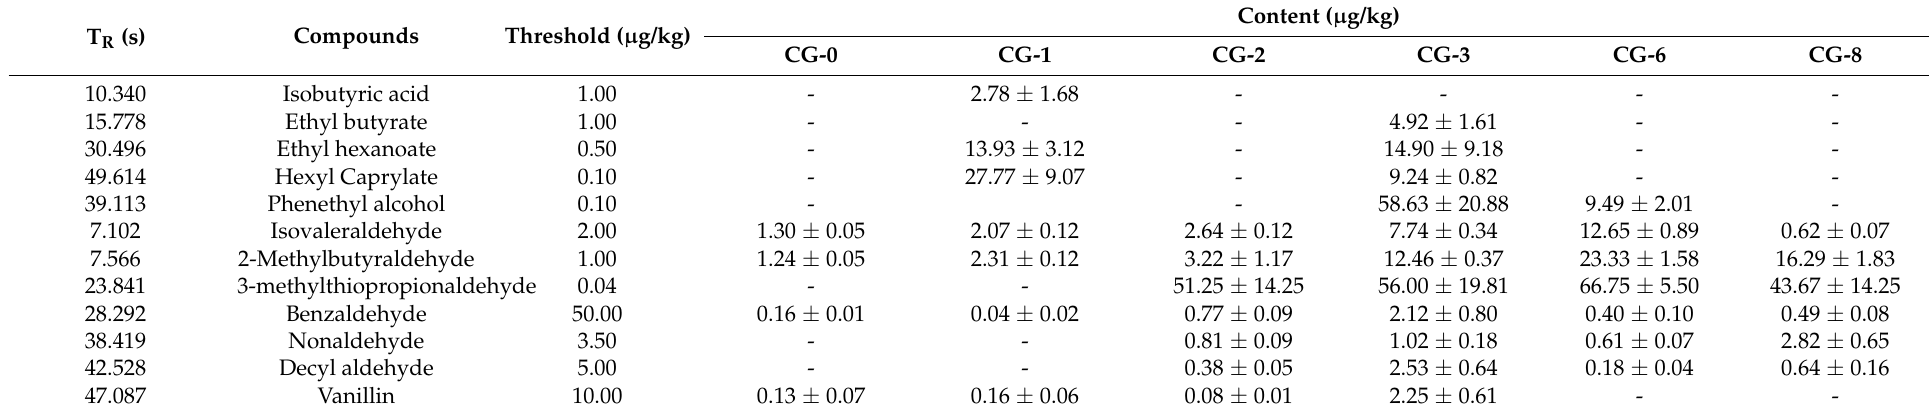
Table 2. Odor activity values (OAVs) of Caishiji soybean paste in different fermentation